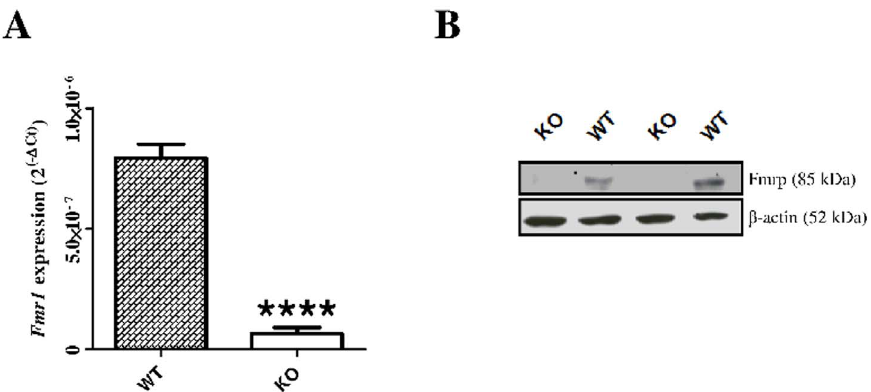
Figure 1. Fmr1/ Fmrp expression in WT and Fmr1 KO retinas. ( A ) Fmr1 mRNA expression was quantified by qPCR (n=8 per group). Data are expressed as 2 2 D Ct values and normalized to 18S RNA internal control. Significant expression of Fmr1 was only found in WT retina. ( B ) Fmrp expression was assessed by Western-blot analysis (n=8 per group). All protein variations were normalized to b -actin. Fmrp was present in WT retinas whereas no detectable protein was observed in Fmr1 KO. Data are presented as Mean 6 SEM. Three independent experiments were performed with similar results. Student’s t test, ****p , 0.0001.